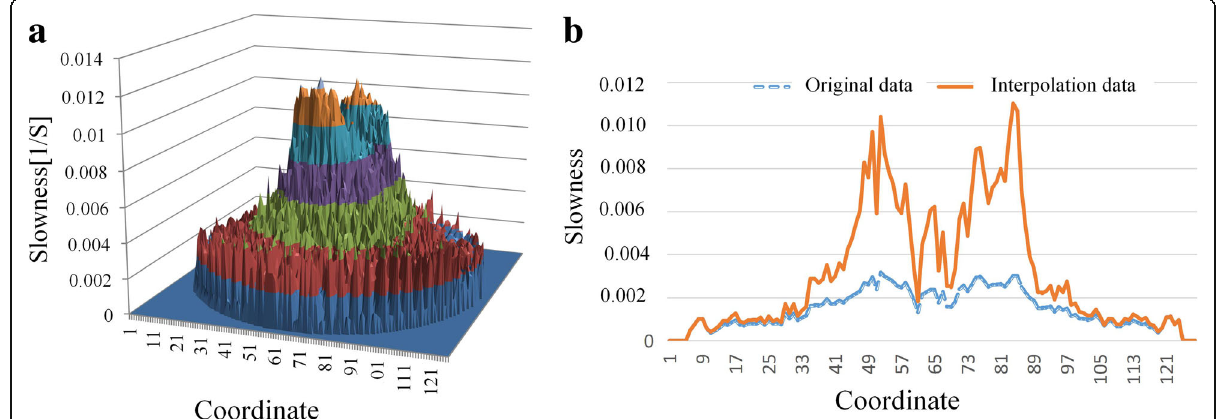
Fig. 11 Slowness of phantom D reconstruction image: a slowness of reconstruction image, b Slowness comarison of orininal data and interpolation